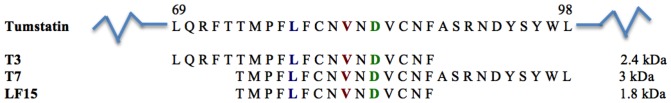
Amino acids sequences of the T3 (2.4 kDa), T7 (3 kDa) and LF15 (1.8 kDa) peptides in comparison to tumstatin (28 kDa).LF15 (amino acids 74–88) encompasses the overlapping region shared by the T3 (69–88) and T7 (74–98) peptides. Peptide integrin binding sites involve the amino acids L (78, Leucine), V (82, Valine) and D (84, Aspartic acid).